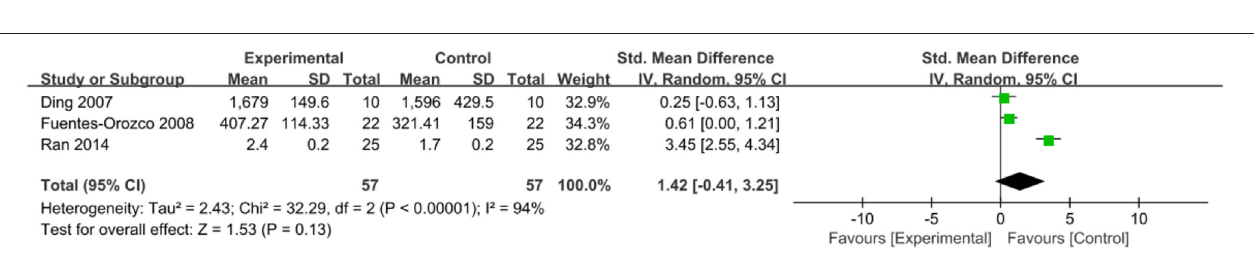
FIGURE 19 | Forest plots of TNF- α associated with experimental group (parenteral or enteral nutrition group supplemented with Gln) vs. control group (conventional nutrition group). I 2 tests and P are the criteria for the heterogeneity test, (cid:7) , pooled standard mean difference; — (cid:4) —, standard mean difference, and the edges of (cid:7) , 95% CI.